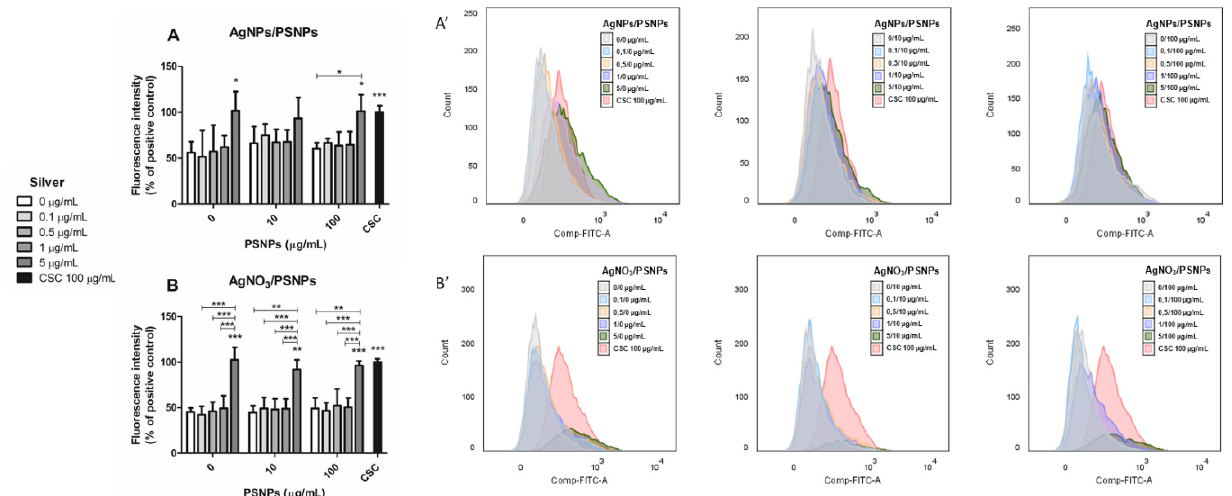
Figure 7. Intracellular ROS production analysis in undifferentiated Caco-2 cells exposed to AgNPs/PSNPs ( A ) or AgNO 3 /PSNPs ( B ) for 24 h. Exposure to 100 μ g/mL CSC was used as the positive control. ROS production was extrapolated from the average of the mean fluorescence intensity from three independent experiments with duplicate samples (10 000 events taken from the living cell population of each sample). Data are represented as the percentage of fluorescence intensity compared to the positive control ± SEM and analysed by one-way ANOVA with the Tukey’s multiple comparison post-hoc test. The histograms showing the fluorescence of the living cell population for each sample treated with AgNPs/PSNPs are represented in ( A’ ). The histograms showing the fluorescence of the living cell population for each sample treated with AgNO 3 /PSNPs are represented in ( B’ ). * p ≤ 0.05, ** p ≤ 0.01, *** p ≤ 0.001